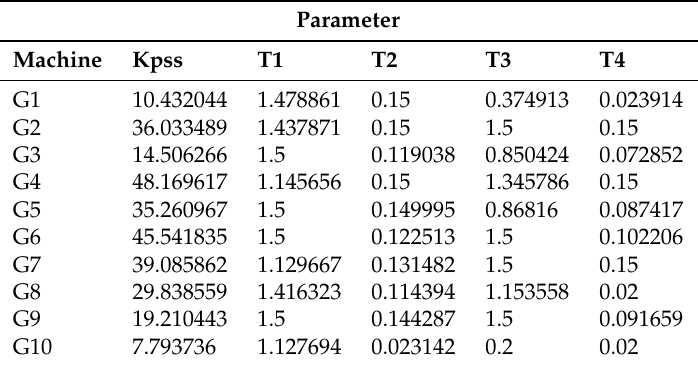
Table 6. Optimal parameters for system